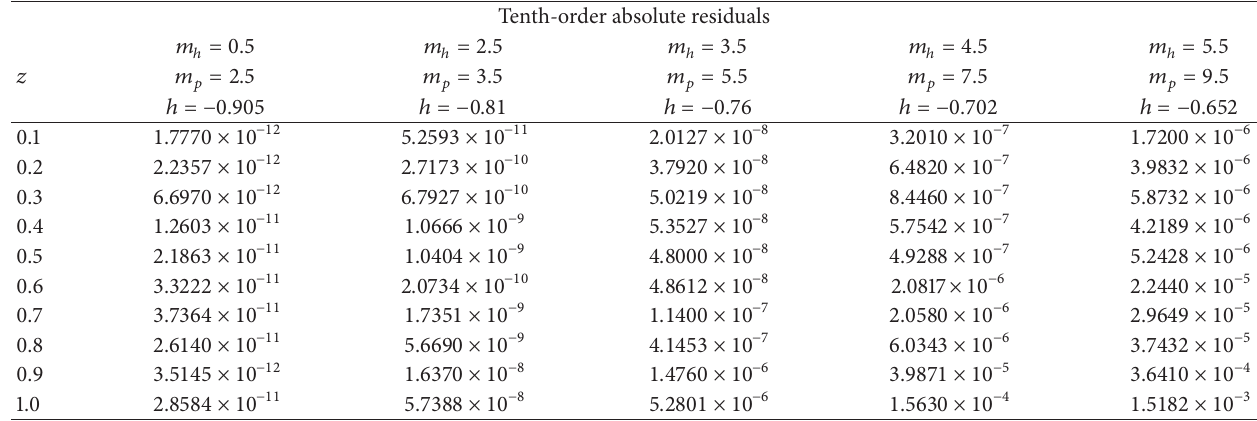
Table 3: Absolute residuals for different values of 𝑚 ℎ , 𝑚 𝑝 and ℎ keeping 𝑅 𝑚𝑝 = 1 .